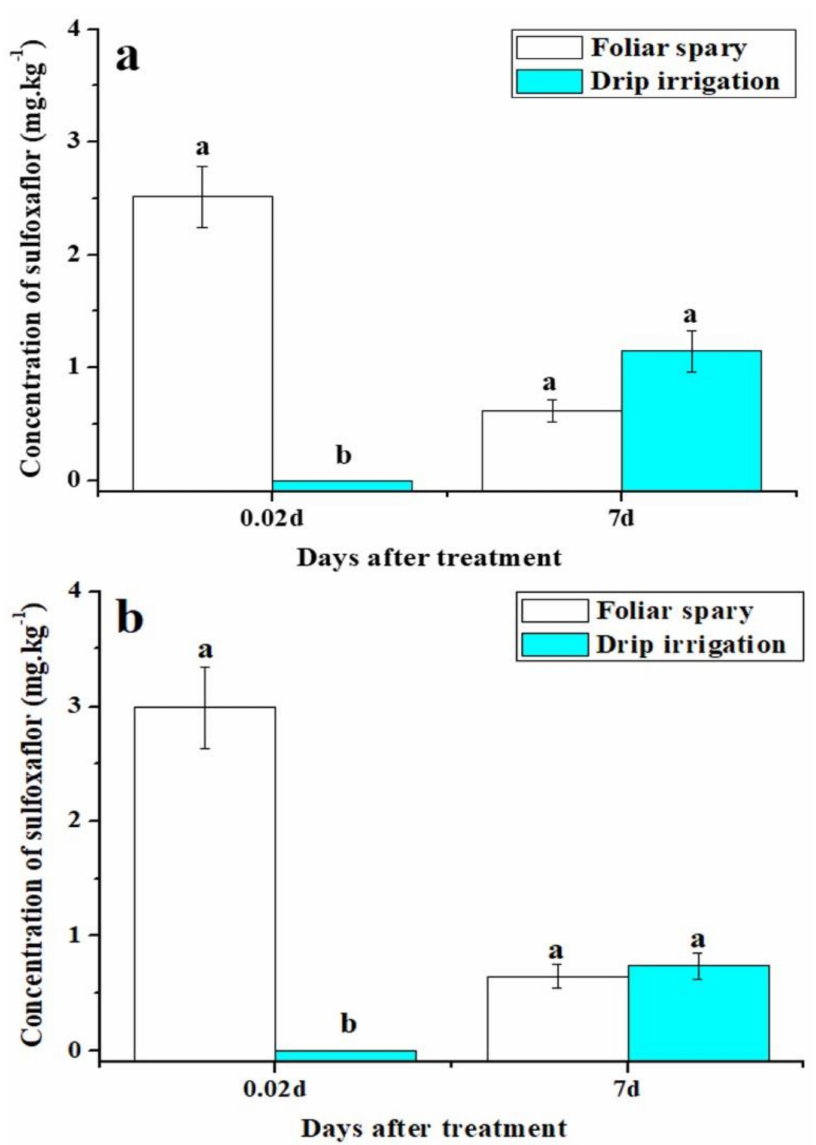
Figure 7. The concentrations of sulfoxaflor in aphids collected from plants applied through drip irrigation and foliar spray in 2016 ( a ) and 2017 ( b ). All data are expressed as mean ± S.E. (n = 3). Di ff erent letters above bars within the same time period are significantly di ff erent based on Tukey’s HSD test at p <